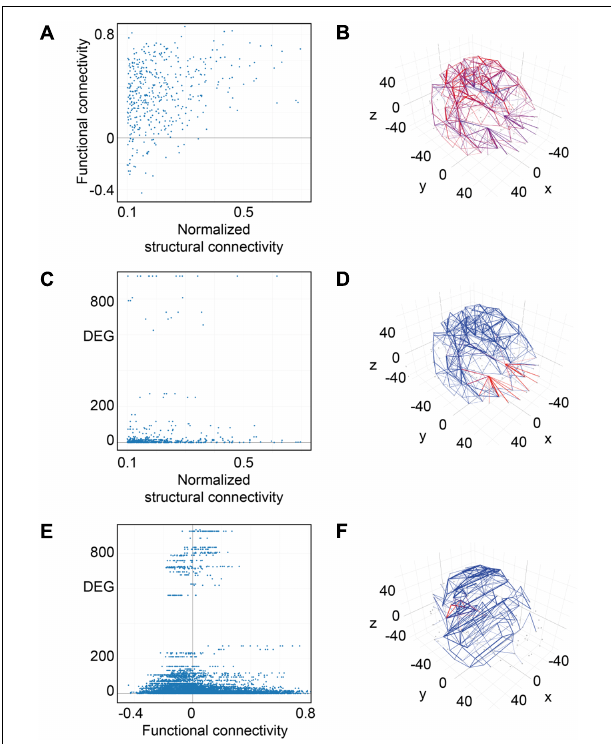
FIGURE 10 | Connectivity vs. differential gene expression. (A) Normalized structural connectivity in terms of normalized fiber density from tractography (diffusion tensor imaging) is plotted against functional connectivity. Functional connectivity indicates the correlation in neural activity over time in the connected brain areas. Only those functional connections that also have a normalized structural connection strength of at least 0.1 were considered. (B) Structural and functional connectivity is depicted in a 3D-lattice graph. Structural connectivity is indicated by line thickness and functional connectivity by line color with red representing correlated neural activity ( > =0.5), purple not correlated ( < 0.5) and blue negatively correlated neural activity ( < 0.0). (C) Normalized structural connectivity plotted against the number of differentially expressed genes (DEG). (D) Connections with an associated high differential expression of genes are surprisingly localized; all of them originate from the left and right putamen. Structural connectivity is indicated by line thickness and differential expression of genes by line color with red indicating high and blue low numbers of differentially expressed genes. (E) Functional connectivity is plotted against differential expression of genes (DEG). We only considered connections with a correlation value of neural activity of 0.5 or higher. (F) 3D-lattice graph of functional connectivity and differential gene expression. Line thickness indicates functional connectivity between values of 0.5 and 1.0 and line color indicates number of differential expression of genes with red high and blue low values. Those few connections with high differential gene expression ( > 200) and with functional connectivity ( > =0.5) originate from occipital fusiform, lingual, parahippocampal, and Heschl’s gyrus.